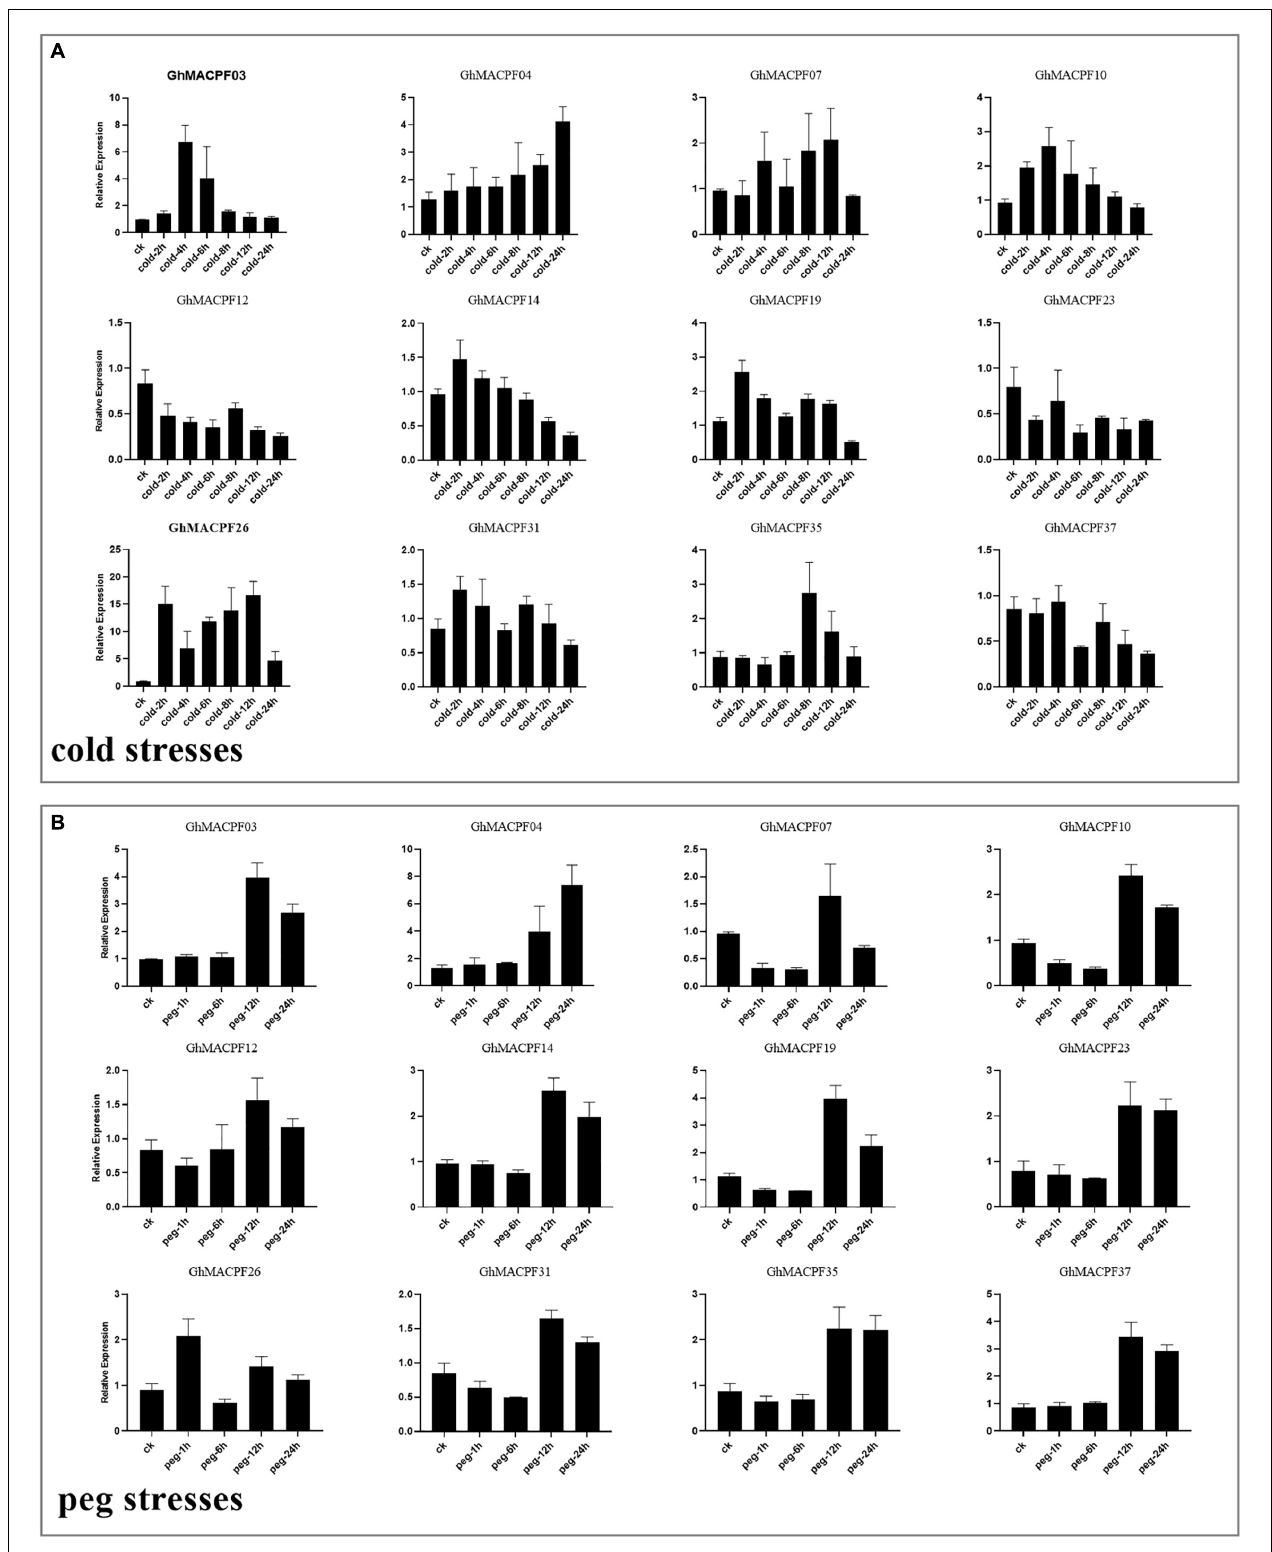
FIGURE 5 | Expression levels of 12 GhMACPF genes in response to the (A) cold and (B) PEG treatment. Gene expression was analyzed by quantitative real-time-PCR (qRT-PCR). Error bars represent the SD of the three biological replicates.